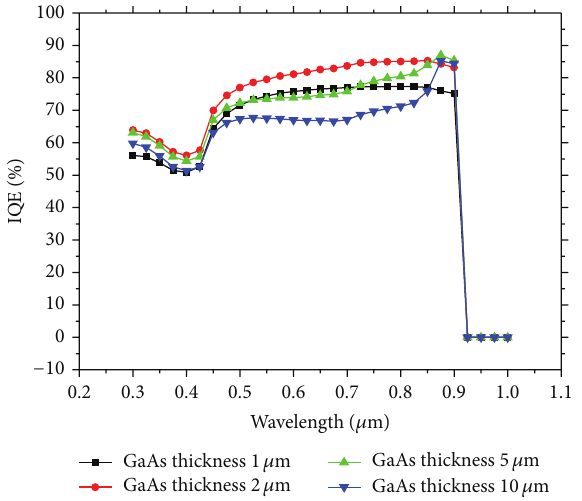
Figure 5: IQE of graphene solar cells versus different GaAs thick- ness.